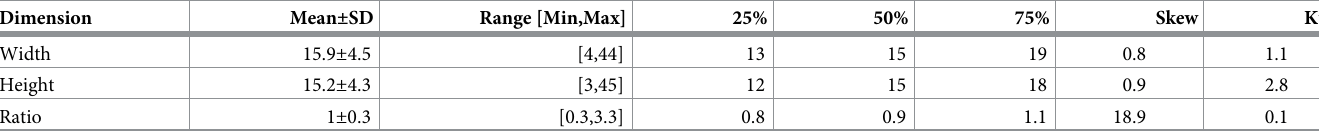
On average, the cells had a width of 15.9 pixels, a height of 15.2 pixels, and a ratio of 1. Nevertheless, their width ranged from 4 to 44 pixels, their height ranged from 3 to 45 pixels, and their ratio ranged from 0.3 to 3.3, demonstrating the cells’ irregular morphology in terms of size and shape. The ratio is calculated by dividing width by height.